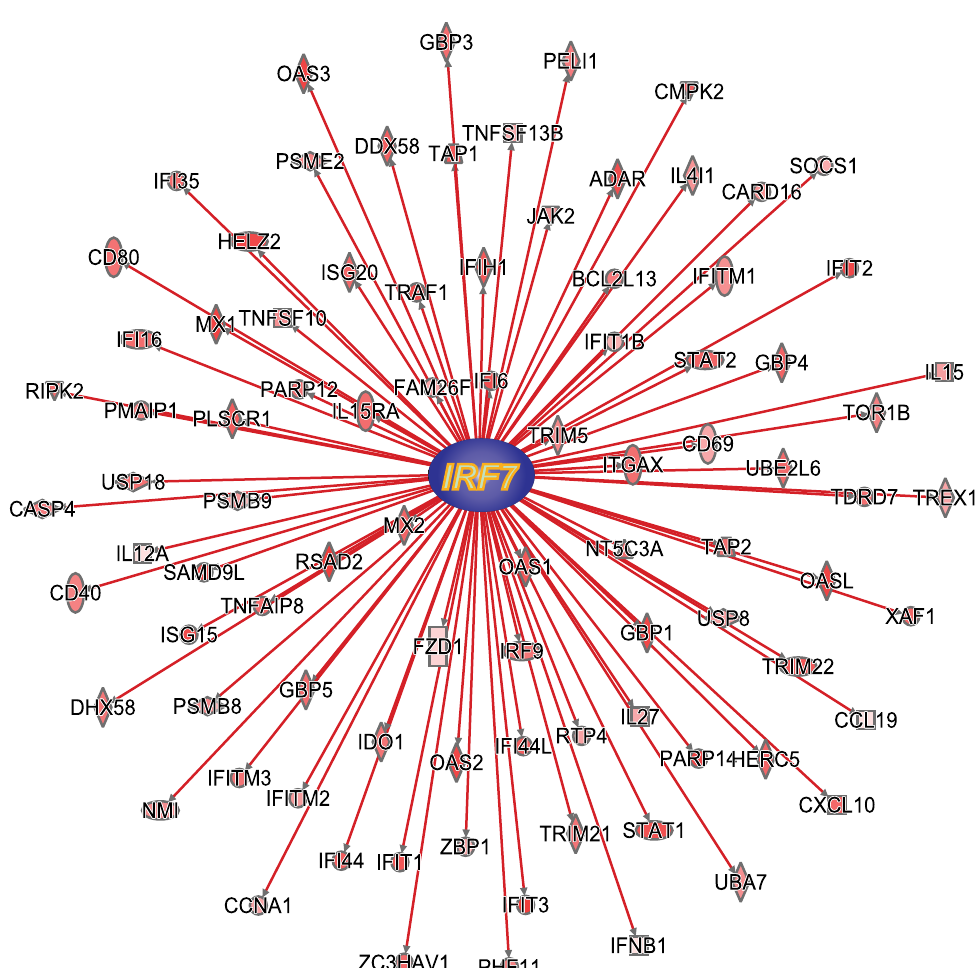
Fig 3. IRF-7 is predicted as a top upstream regulator of 89 known gene targets. Analysis of RNA-Seq dataset was performed with Ingenuity Pathway Analysis software, which predicted IRF-7 to be the top upstream regulator (overlap p-value = 3.5x10 -37 , Fisher ’ s Exact test, z-score 9.28, n = 5). The increased expression of IRF7 is consistent with the increased expression state of 89 known target genes, predicted from the literature. Red lines connecting the upstream regulator and the target gene represent a positive consistent correlation. A red colored molecule represents the gene is upregulated in the dataset. More intense red color represents higher expression level state in the